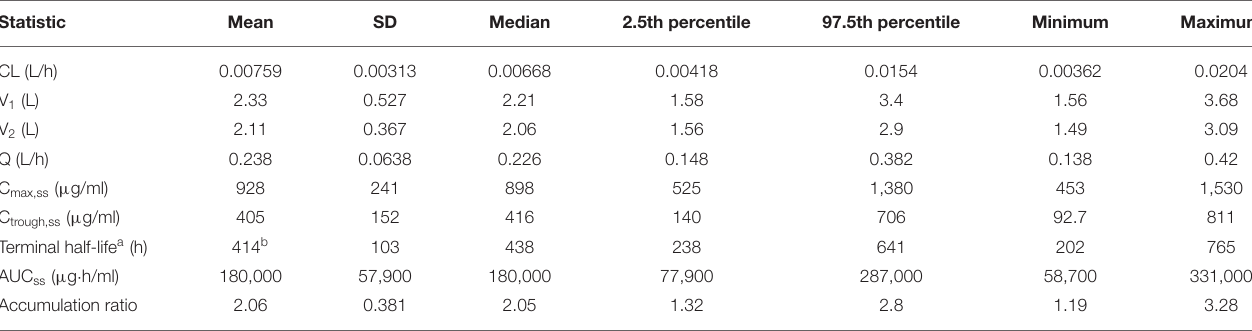
TABLE 2 | Summary of estimated pharmacokinetic